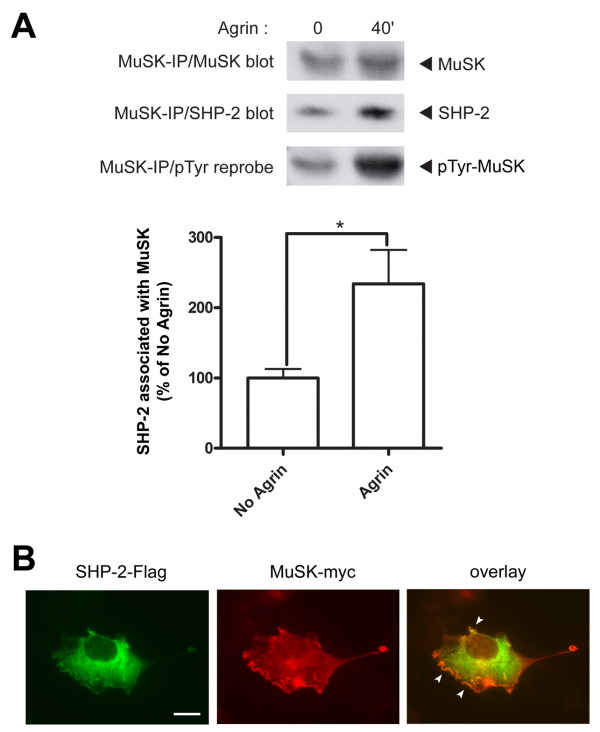
Protein tyrosine phosphatase SHP-2 increasingly associates with MuSK upon agrin stimulation. (A) C2C12 myotubes were treated with 0.5 nM agrin for 40 min. Following MuSK immunoprecipitation, immunoblotting for SHP-2 and MuSK was carried out, followed by reprobing for phosphorylation of MuSK. Levels of SHP-2 co-precipitated with MuSK were quantitated (normalized for the amount of precipitated MuSK) as percentage of No Agrin control. Co-immunoprecipitation of SHP-2 with MuSK indicates its specific association with MuSK, which increases significantly upon agrin-induced MuSK phosphorylation (means ± SEM, from seven experiments; * p < 0.05; two-tailed unpaired t test). As a control, the MuSK antibody was omitted in the immunoprecipitation, leading to no substantial signal in the Western blots (not shown). (B)COS cells were co-transfected with SHP-2-Flag and MuSK-myc constructs. Cells were then fixed and stained with anti-Flag/Alexa488 and anti-myc/Alexa546 antibodies. SHP-2 localizes throughout the whole of the cytoplasm, while MuSK localization is concentrated along the plasma membrane. White arrowheads in the overlay indicate a colocalization of MuSK and SHP-2 along membrane ruffles on the plasma membrane. Scale bar, 40 μm.